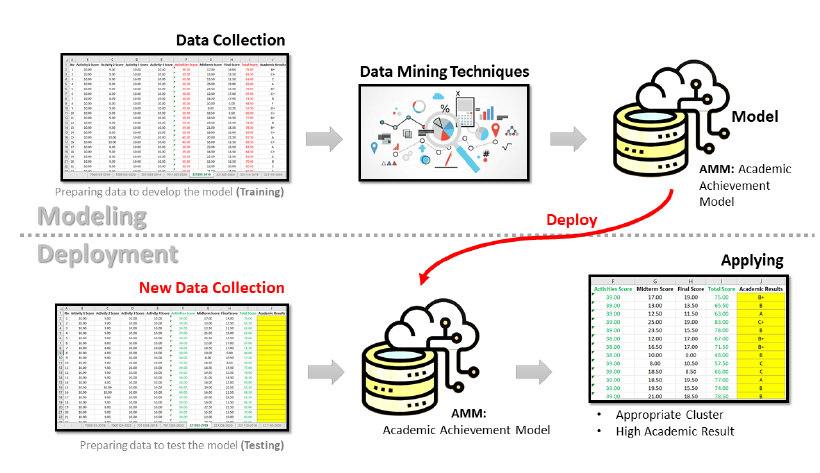
Fig. 2. Academic achievement